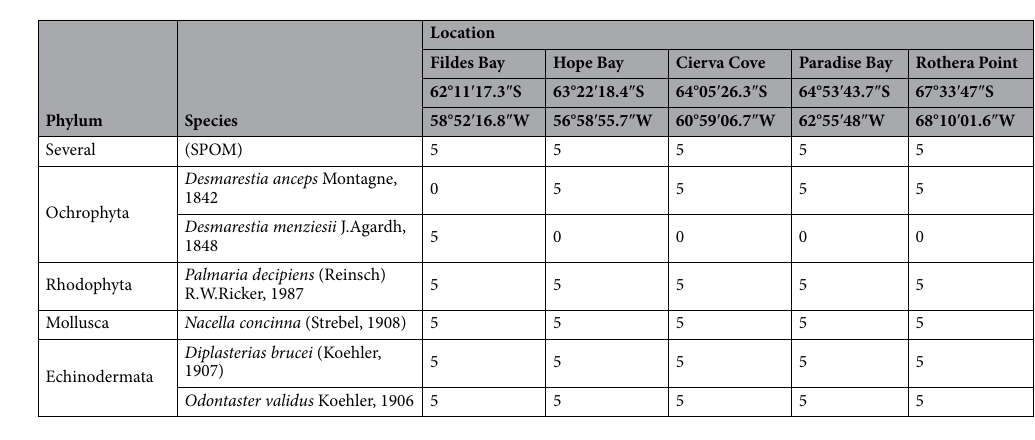
Table 1. Taxa, number and sites of collection of the samples. SPOM Suspended Particulate Organic